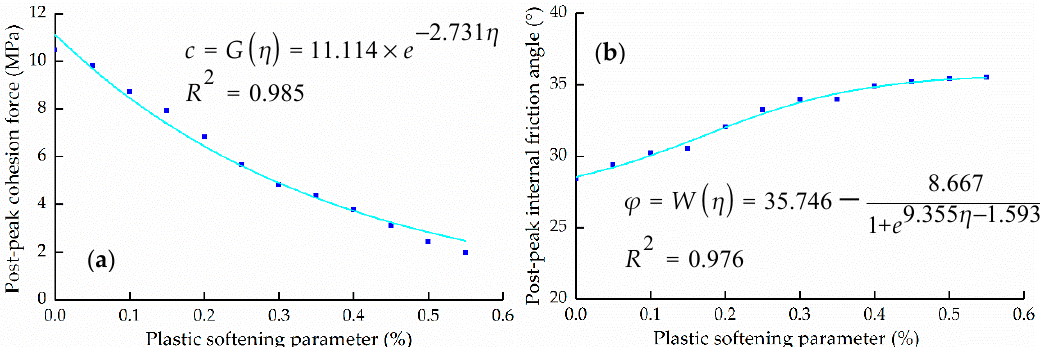
Figure 4. Regression curves of ( a ) cohesion force vs. plastic softening parameter and ( b ) internal friction angle vs. plastic softening parameter.